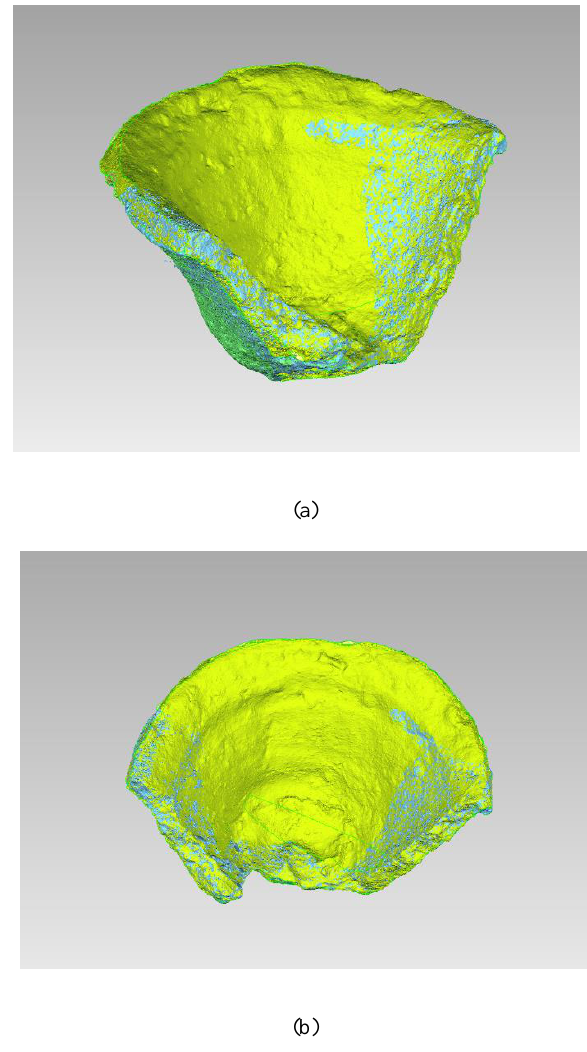
Figure 11. (a,b) Combining of all point clouds from five chunks (six millions of triangles)